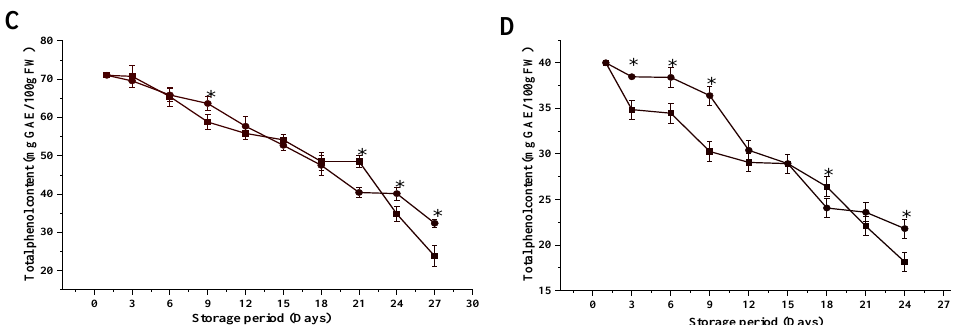
Figure 5. Total flavonoid content ( A , B ) and total phenol content ( C , D ) of ‘Guiqi’ ( A , C ) and ‘Tainong 1’ ( B , D ) fruits treated with 1000 µ mol L − 1 MT. Each value is the mean for three replicates, and vertical bars indicate the standard error (SE). Error bars with an asterisk (*) on the same storage period show a significant difference between the treatments ( p < 0.05).